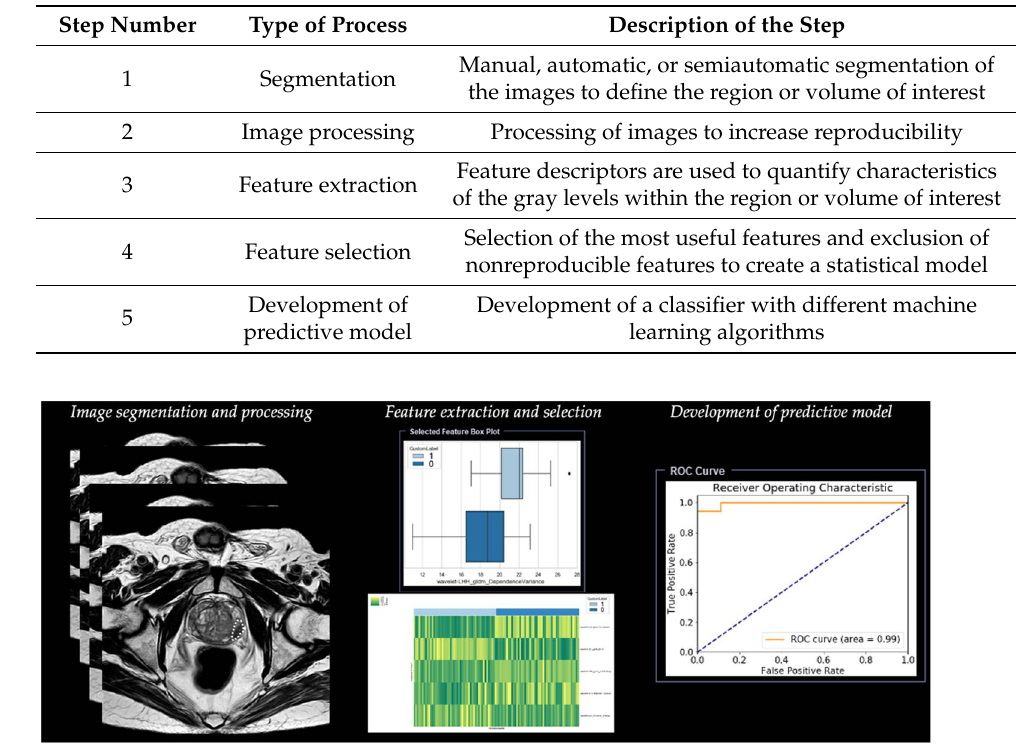
Figure 3. Workflow of radiomics for prostate cancer in a simulated study on T2-weighted images using a prototype research software Radiomics, version 1.0.9 (Siemens Healthineers, Forchheim, Germany).